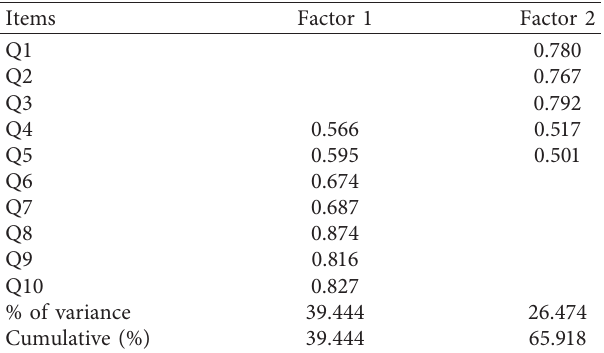
loading of the items on the two